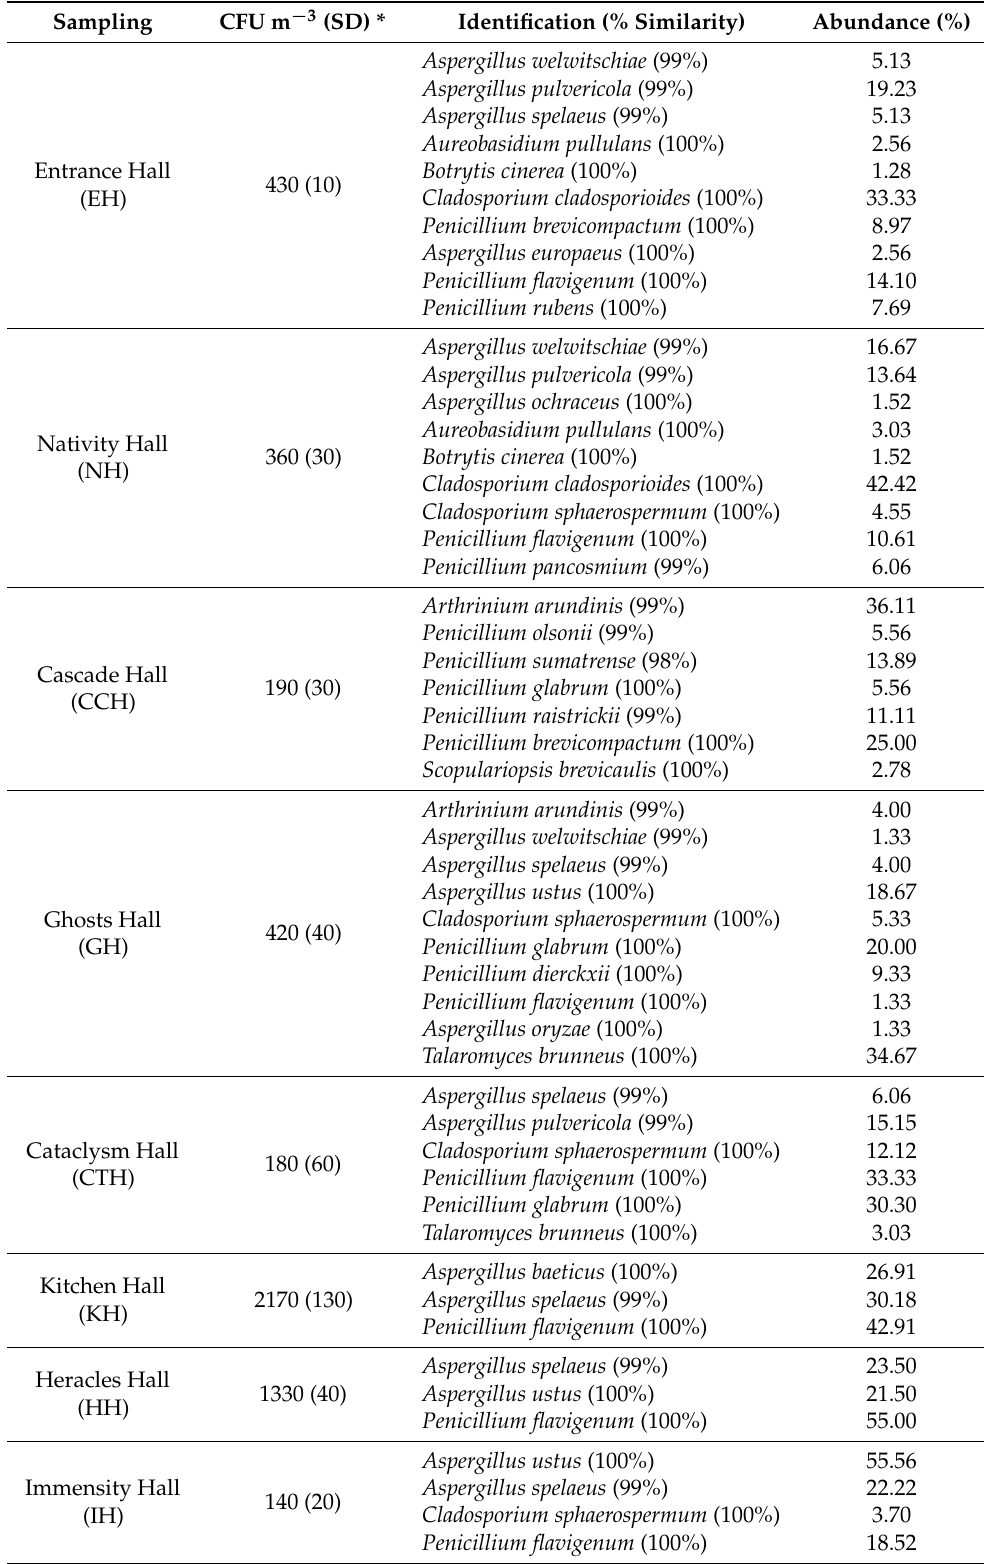
Table 3. Total counts, identifications, and abundance of fungi isolated from Nerja Cave in 2017 winter